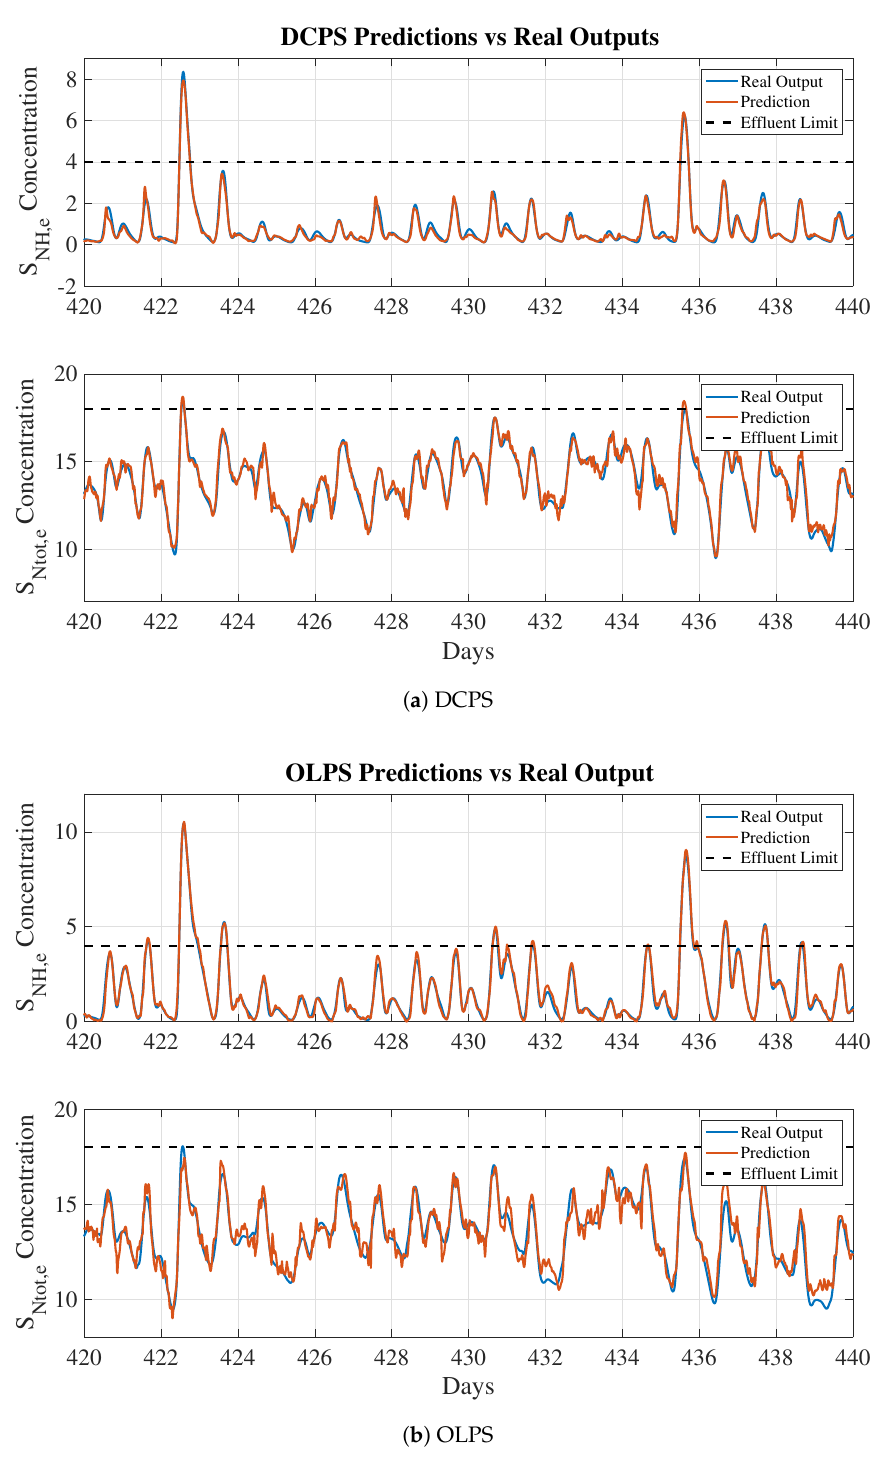
Figure 13. DCPS and OLPS performed predictions vs. real